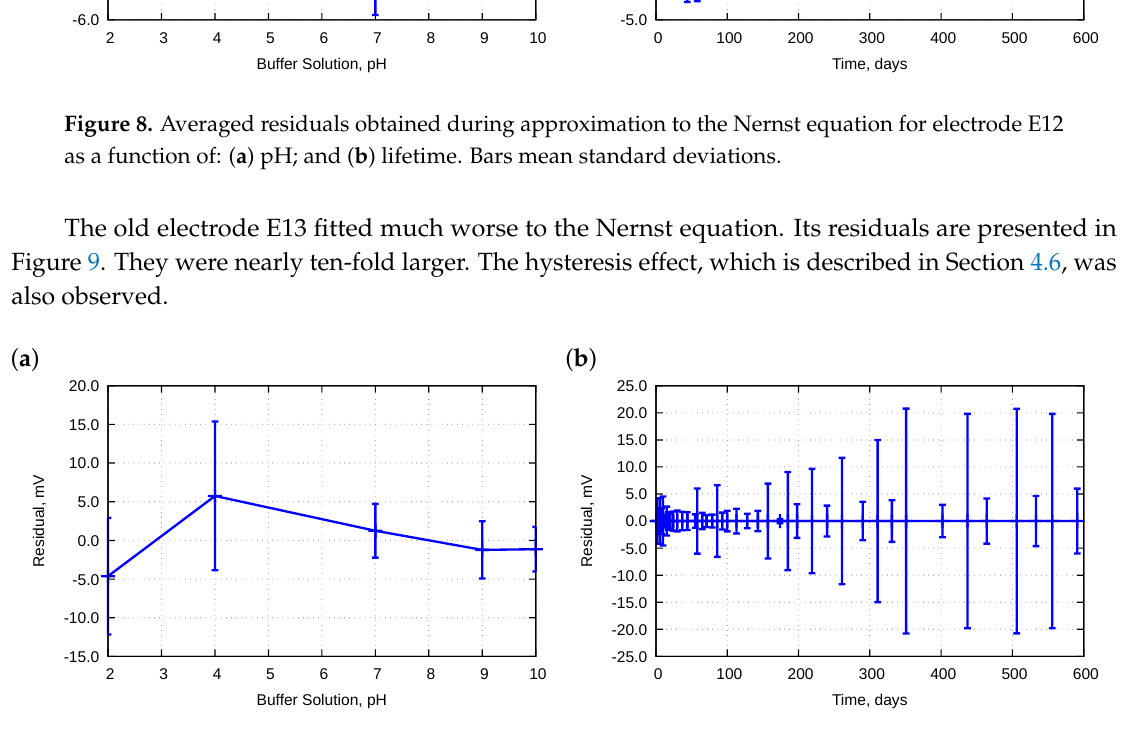
Figure 9. Averaged residuals obtained during approximation to the Nernst equation for electrode E13 as a function of: ( a ) pH; and ( b ) lifetime. Bars mean standard